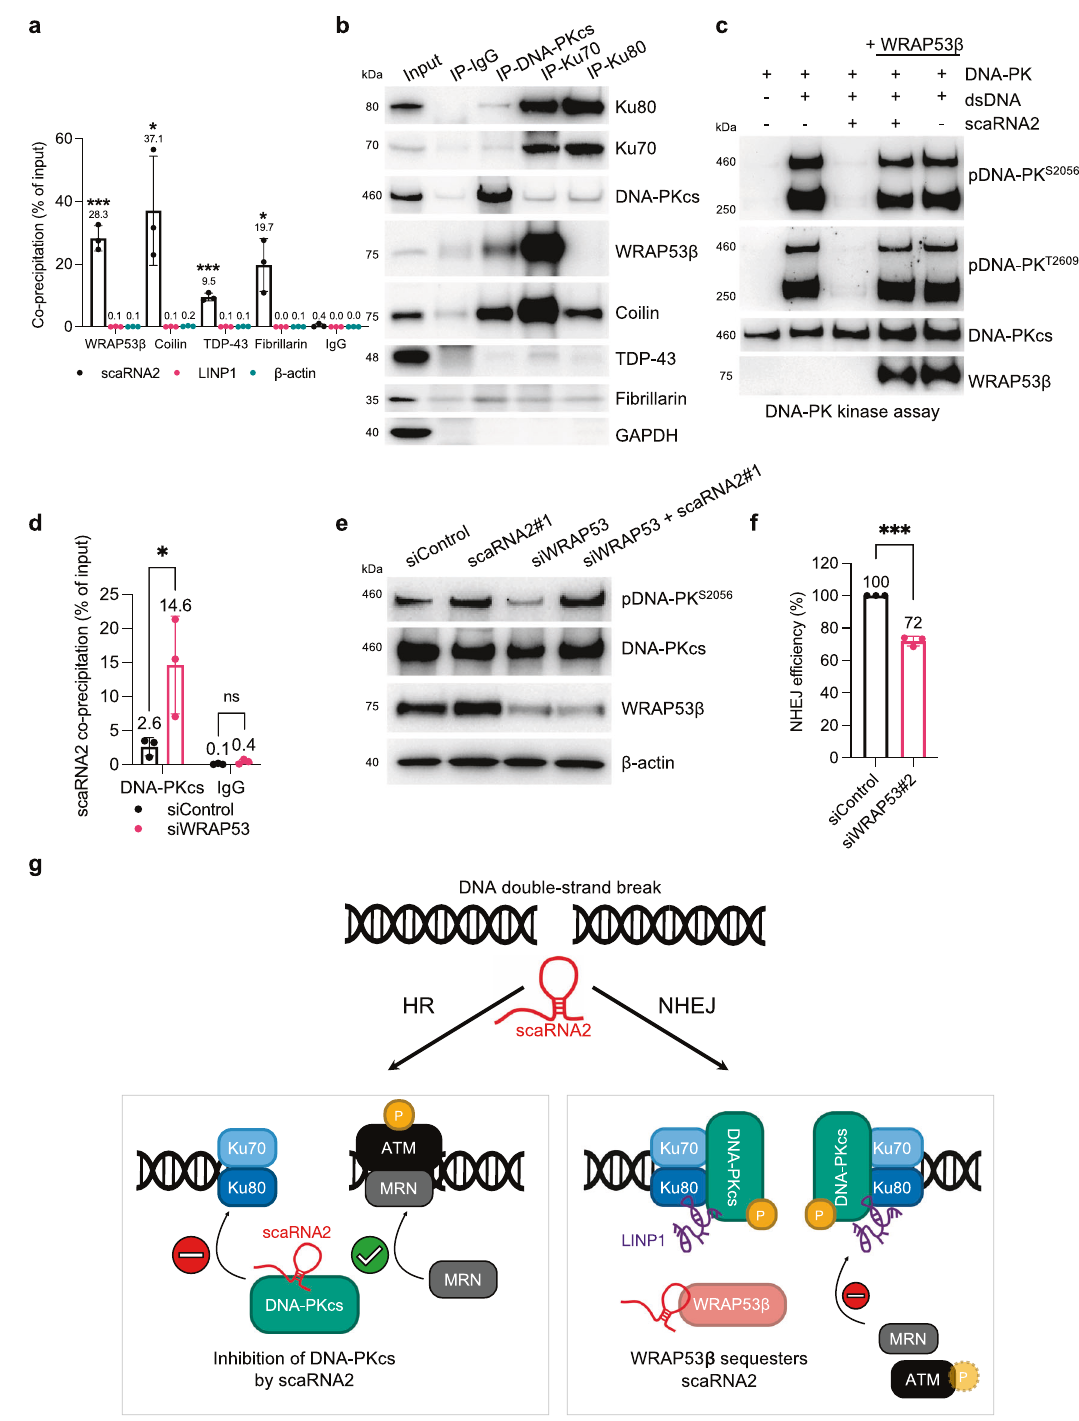
and the numbers on the graphs indicate the percentage of these cells where the repair factor co-localized with the mCherry-FokI dot.